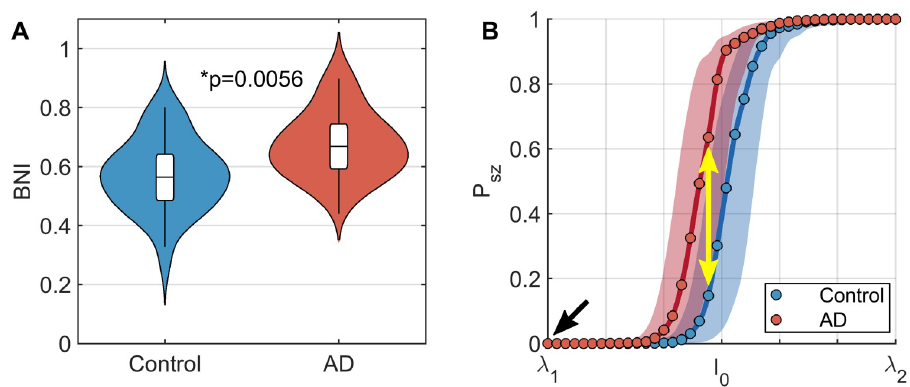
Fig 2. Functional brain networks in AD are more susceptible to seizure generation in response to increase cortical excitability than controls. (A) Violin plots of BNI in people with AD and controls. BNI is significantly higher in AD. (B) Plots of seizure likelihood, P , against excitability, I 0 . Lines show median values over all participants within a sz group, while shaded regions show interquartile ranges. Circles show the grid of values on which I 0 was simulated. The values of BNI shown in subplot A are the area under these curves for each participant. The black arrow shows a hypothetical ‘current’ baseline, in which no participants have seizures. The yellow arrow shows that if cortical excitability increases, AD participants are more likely to experience seizures than controls. Parameters: K = 10, λ 1 = − 1.7, and λ 2 = −